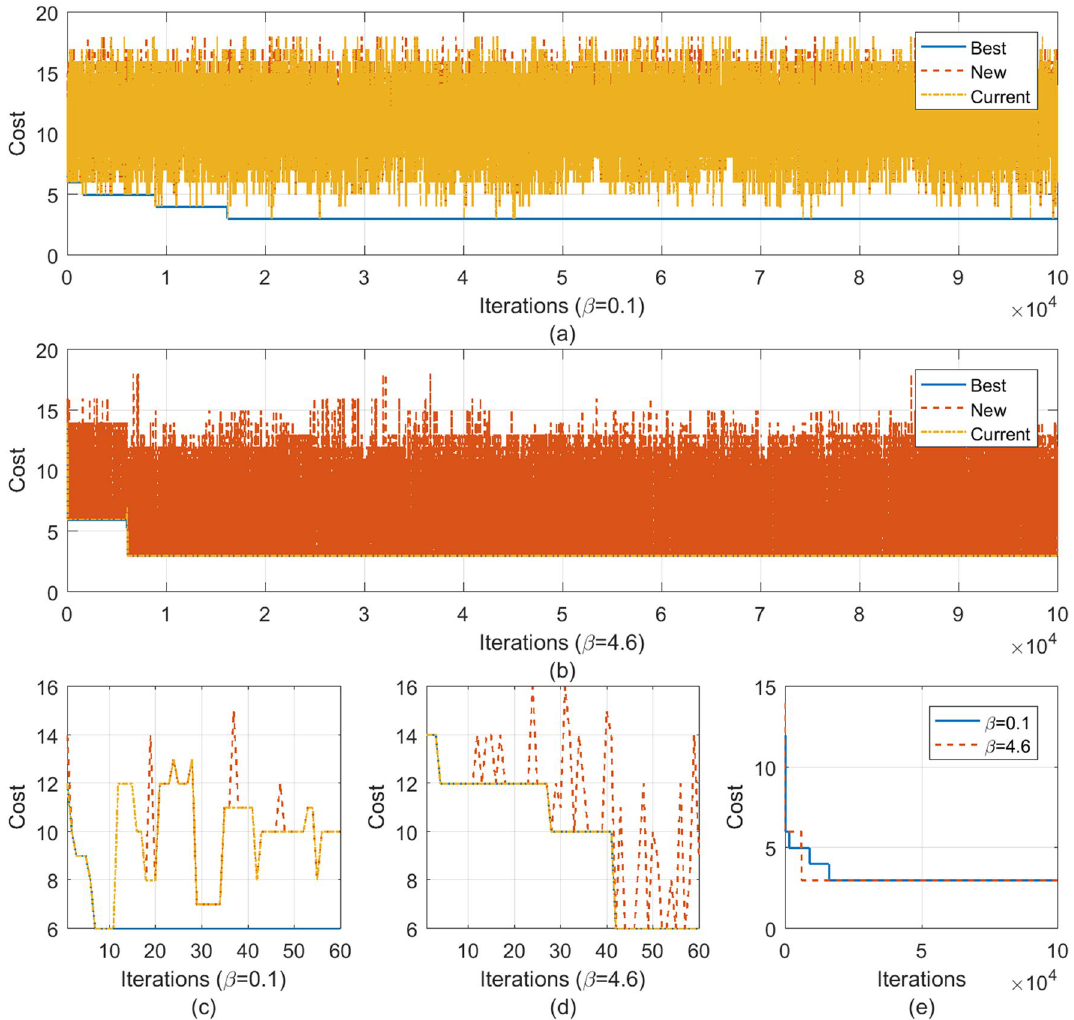
Figure 2. Experimental results on stochastic quantum program synthesis. ( a ) shows the average cost of the best, new, and current programs when β equals 0.1. Small β means random exploration, which can be demonstrated by the current program cost. ( b ) shows the average cost of the best, new, and current programs when β equals 4.6. Large β means hill climbing, which can be demonstrated by the current program cost, which is equal to the best program cost. ( c , d ) show the first 60 iterations to illustrate the variation of different costs. ( e ) compares the best program costs when β equals 0.1 and 4.6, which validates that β plays a partial role in the convergence of stochastic synthesis